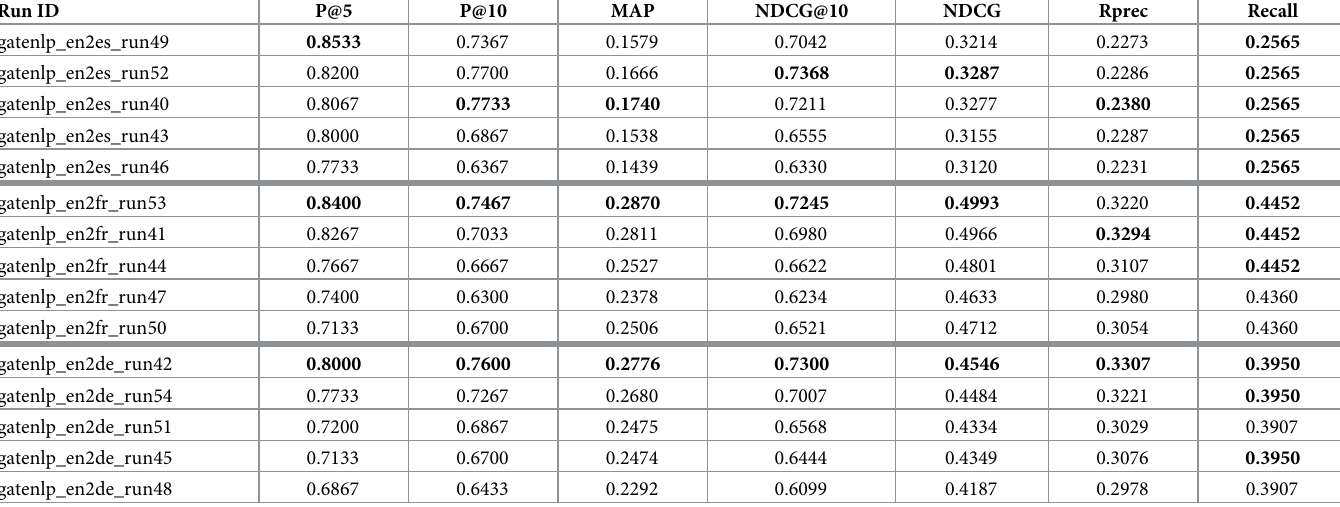
Table 7. Results for bilingual Spanish (es), French (fr) and German (de) runs. Here the language of query is English and language of documents is depicted by ISO 639- 1 code after gatenlp_en2 identifier in the run name. All runs retrieve 200 documents per query. Best overall scores are highlighted in bold. Run